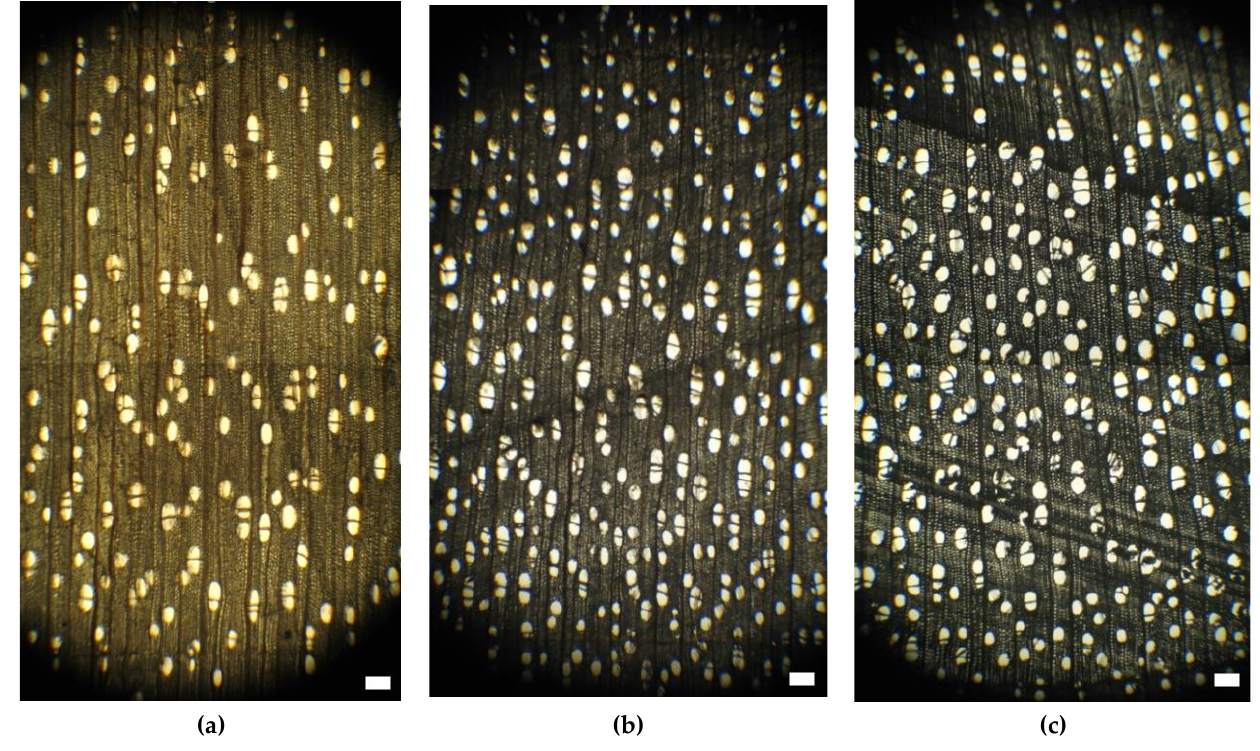
Figure 2. OBM micrographs of birch ( Betula pendula Roth, ×4) on transverse section of small clear specimen, cut out from disc at a height of 1 ( a ), 5 ( b ) and 9 ( c ) meters from the stem base. Scale bars = 100 µm.